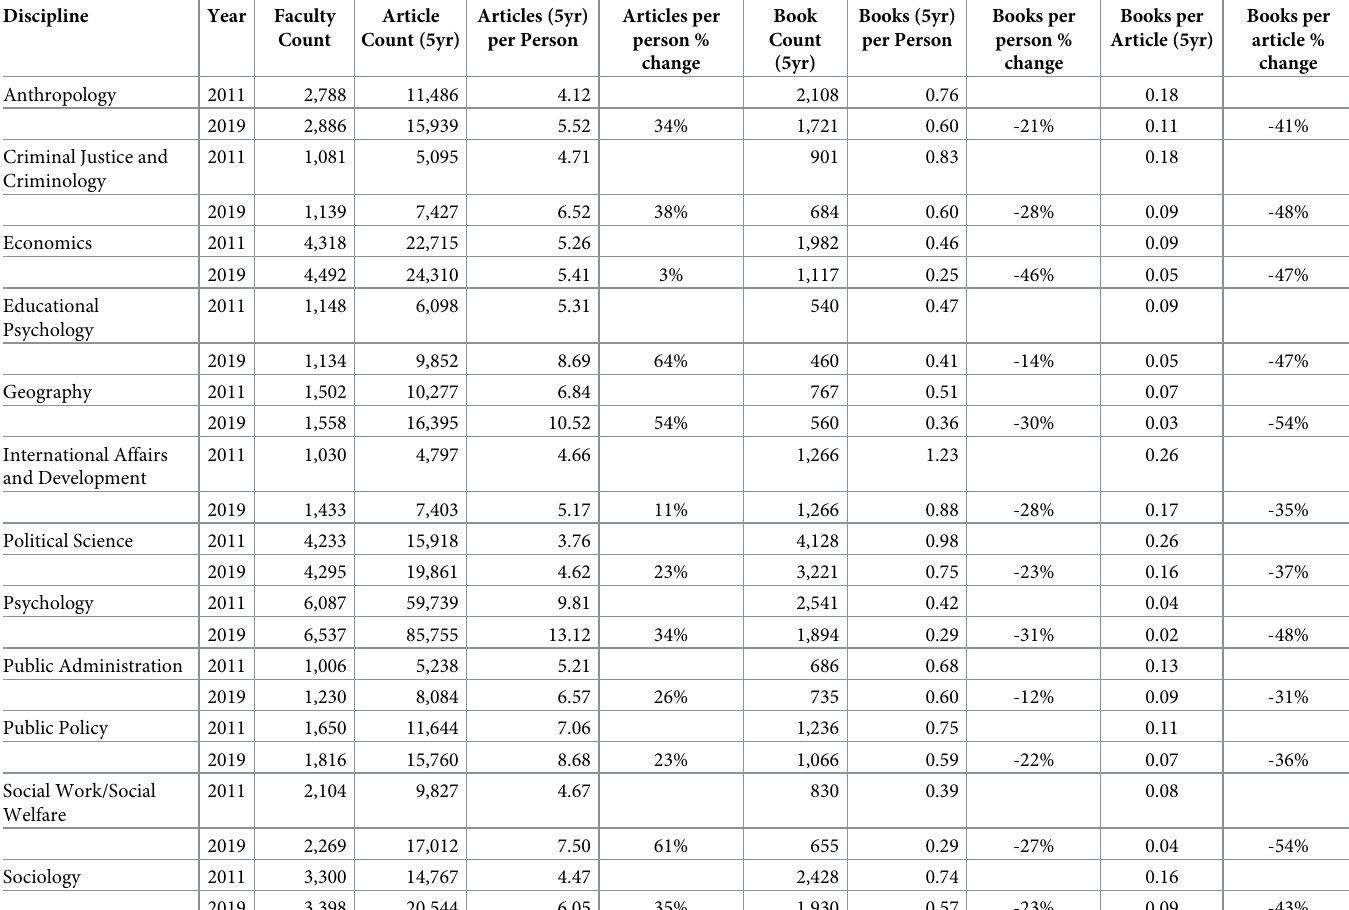
Table 2. Faculty, article (5-year count), and book (5-year count) totals and ratios in 2011 and 2019.